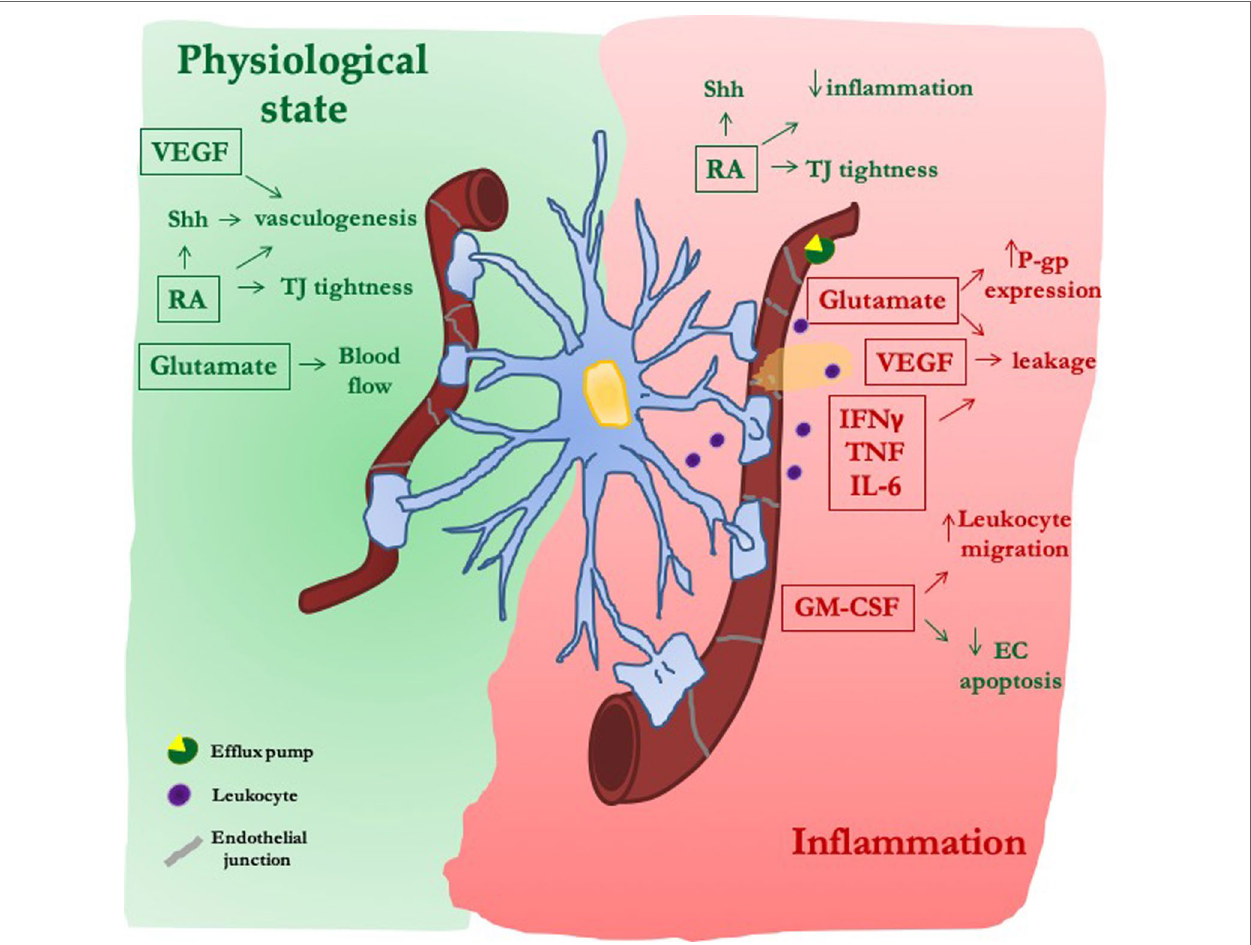
FIGURe 2 | The dual role of astrocytic-derived factors on blood–brain barrier (BBB). Under physiological conditions, astrocytes release morphogens [sonic hedgehog (Shh) and retinoic acid (RA)], trophic factors (VEGF), and gliotransmitters (Glu) that, reinforcing both the formation of new vessels and the tightness of their junctions, improve the proper endothelial function at the BBB. After inflammatory stimuli, secretion of morphogens (Shh and RA) is reactivated in an attempt to reduce the inflammatory-mediated damage on endothelial layer. On the contrary, VEGF and Glu induce junctional damage and BBB leakiness, as well as increased expression of efflux pumps [P-glycoprotein (P-gp)]. The secretion of cytokines and chemokines is further increased, thus facilitating BBB leakage and leukocyte migration.